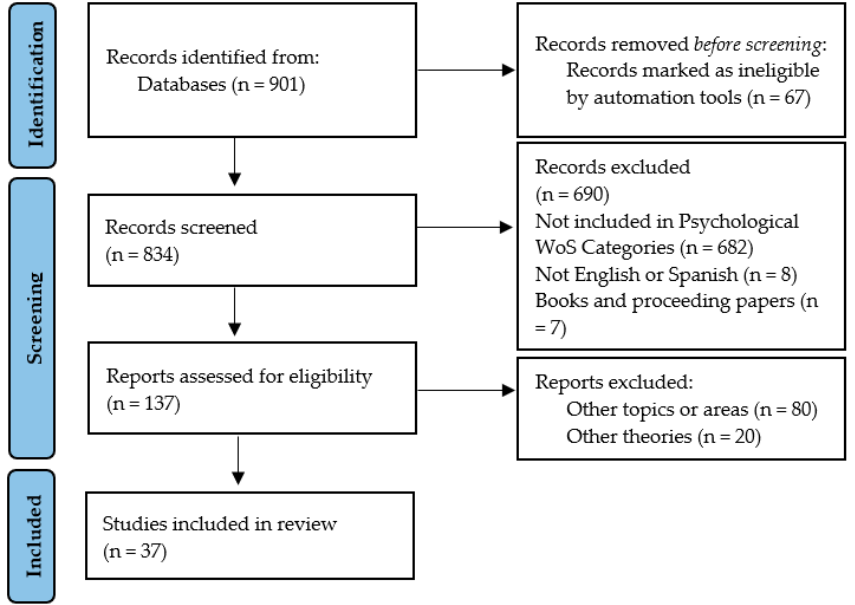
Figure 1. Flowchart of the selection and screening process of the systematic review articles according to the PRISMA method.